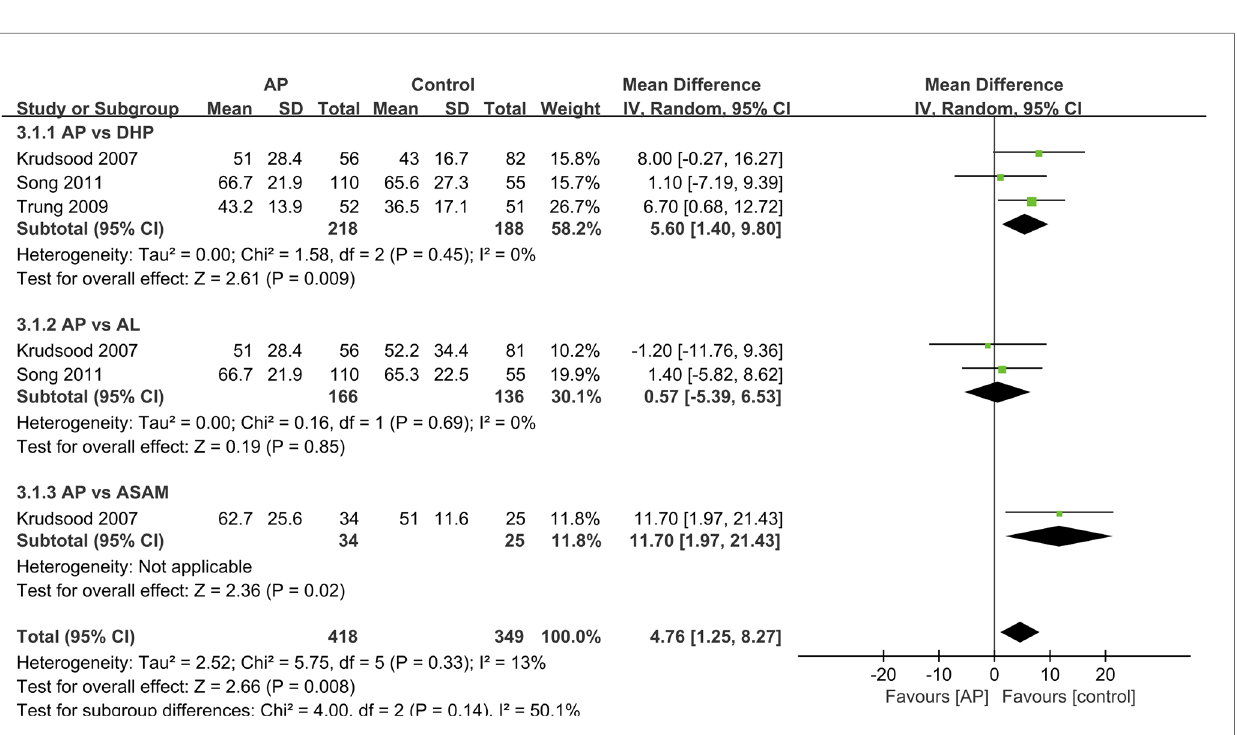
FIGURE 4 | Comparative parasite clearance time (PCT) between ATQ and competing